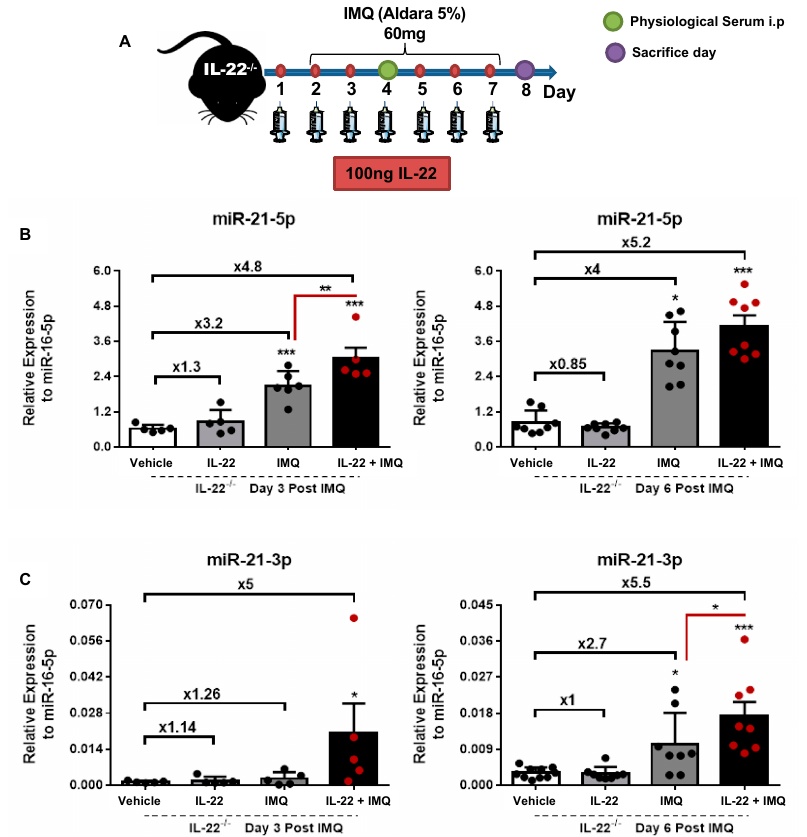
Figure 3. miR-21 induction in psoriasis is IL-22-dependent. ( A ) Schematic representation of IMQ- induced psoriasiform or control mice (vehicle application)—time course of IL-22 − / − mice that received 100 ng of IL-22 or an equivalent amount of physiological serum subcutaneously on the shaved area, one day before the induction of pathogenesis and up to day 7. ( B ) Relative expression of miR-21-5p to miR-16-5p at day 3 and day 6 post-IMQ application in vehicle mice (white histogram), IL-22-treated mice (light gray histogram), IMQ induced psoriasiform mice (dark gray histogram), and IMQ-induced psoriasiform mice treated with IL-22 (black histogram). ( C ) Relative expression of miR-21-3p to miR-16-5p at day 3 and day 6 post-IMQ application in vehicle mice (white histogram), IL-22-treated mice (light gray histogram), IMQ-induced psoriasiform mice (dark gray histogram), and IMQ-induced psoriasiform mice treated with IL-22 (black histogram). Data information: results are presented as mean values ± SEM. Data are representative of two independent experiments with at least five mice per group. The statistical comparison between groups was performed using two-way ANOVA: * p < 0.05, ** p < 0.01, *** p <